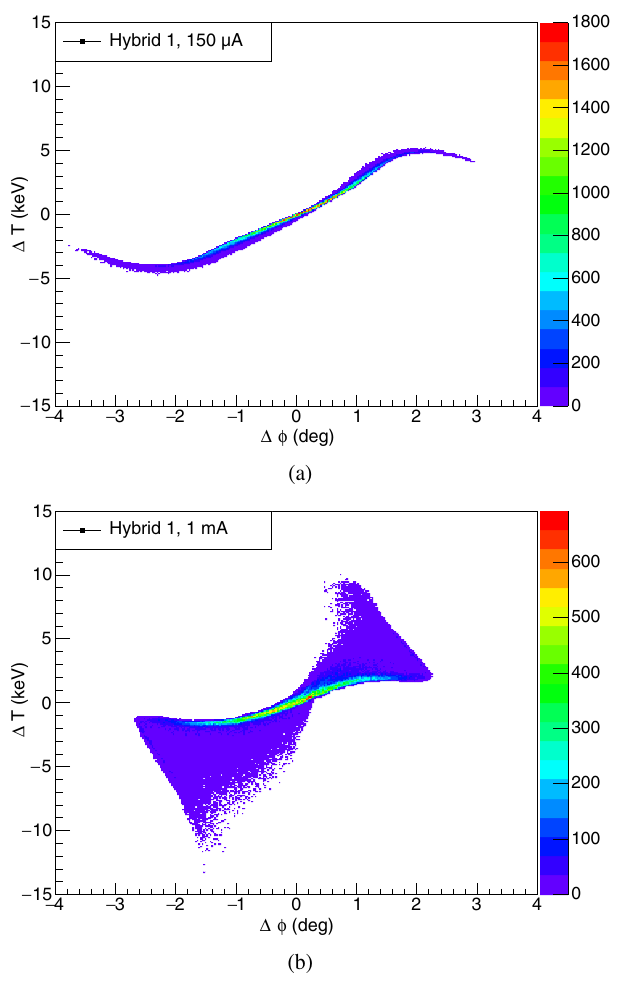
FIG. 7. Phase space distributions of the particles at the end of hybrid MAMBO version 1 at I 1 mA (Fig. 7b). Bunch length, energy spread and emittances are listed in Table